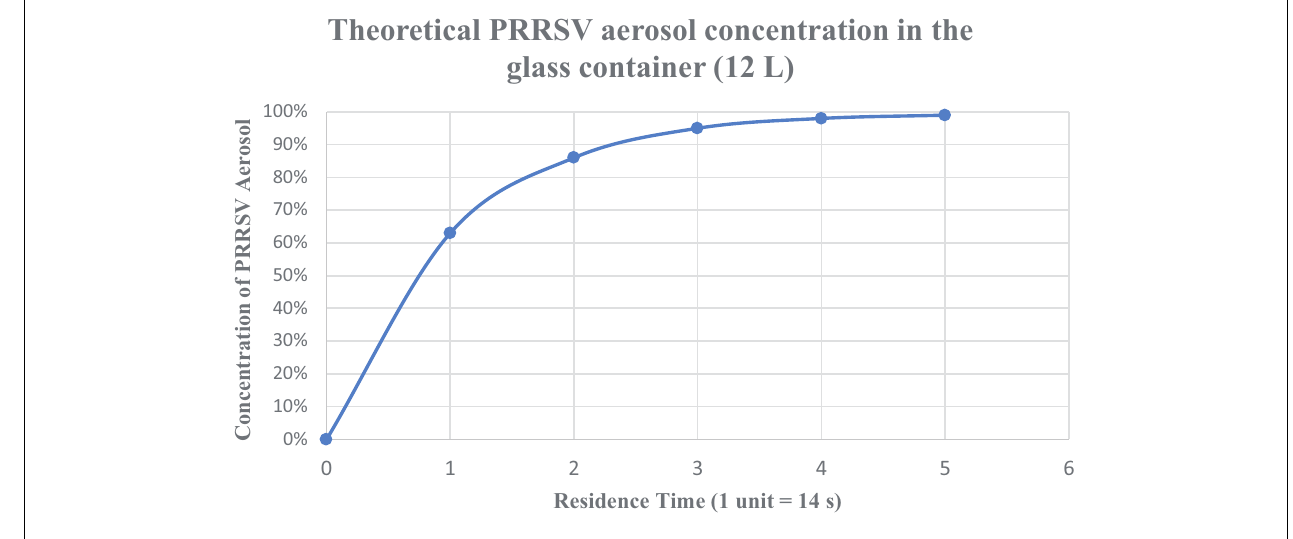
FIGURE 4 | Steady-state conditions for the aerosolized virus. Theoretical PRRSV aerosol concentration in the glass container (12 L) with respect to the operation time (expressed in terms of the aerosol residence time within the glass container).